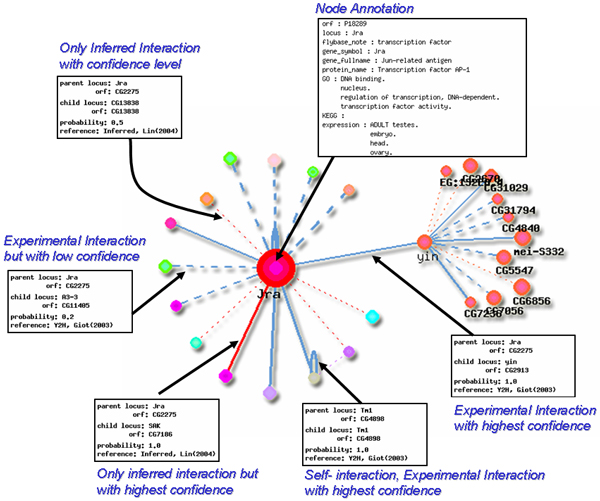
The map of network. A map of the experimental and inferred visualized protein interaction networks of Drosophila melanogaster. The solid/dotted lines in blue indicate that these interactions exist in experimental results with high/low confidence. The solid and dotted lines in colors (adopted from the color of protein) other than blue respectively depict the putative relations with possibilities equal to one and less than one. Information on edges and nodes is instantly displayed with messaging boxes when the cursor is placed over. The network is expended dynamically with a double-click on the node.